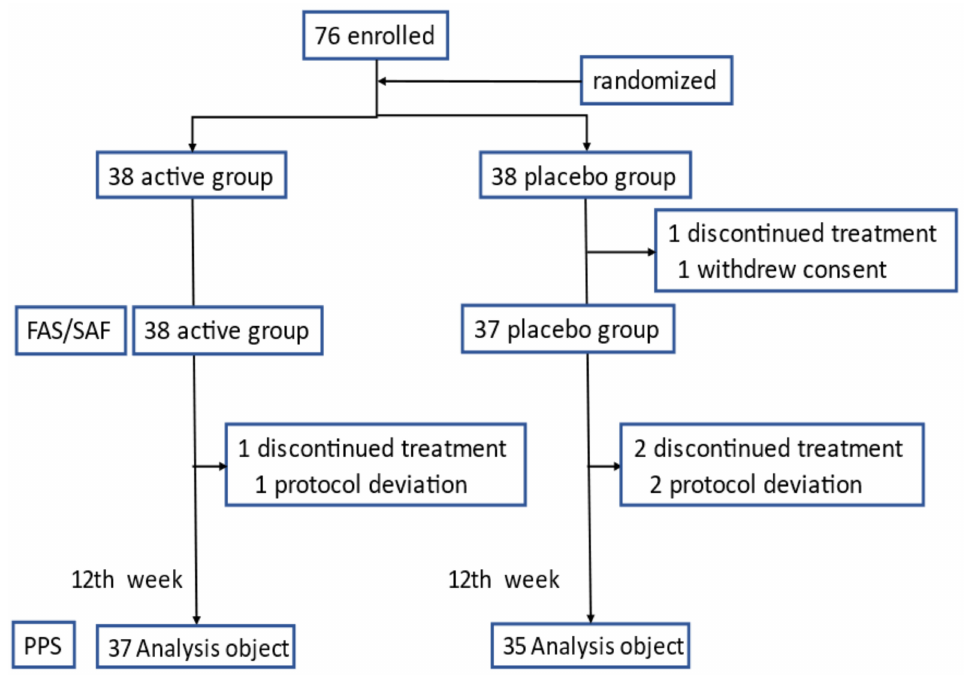
Figure 1. Flow diagram of participants throughout the study. FAS/SAF: Full Analysis Set/Safety Analysis Set; PPS: Per Protocol